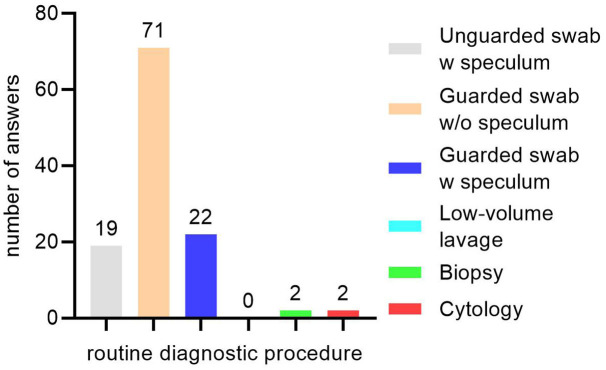
Routine diagnostic procedures for equine endometritis performed by practitioners in Germany. Number above columns indicate the number of answers for the specific diagnostic tool. “w,” with; “w/o,” without.